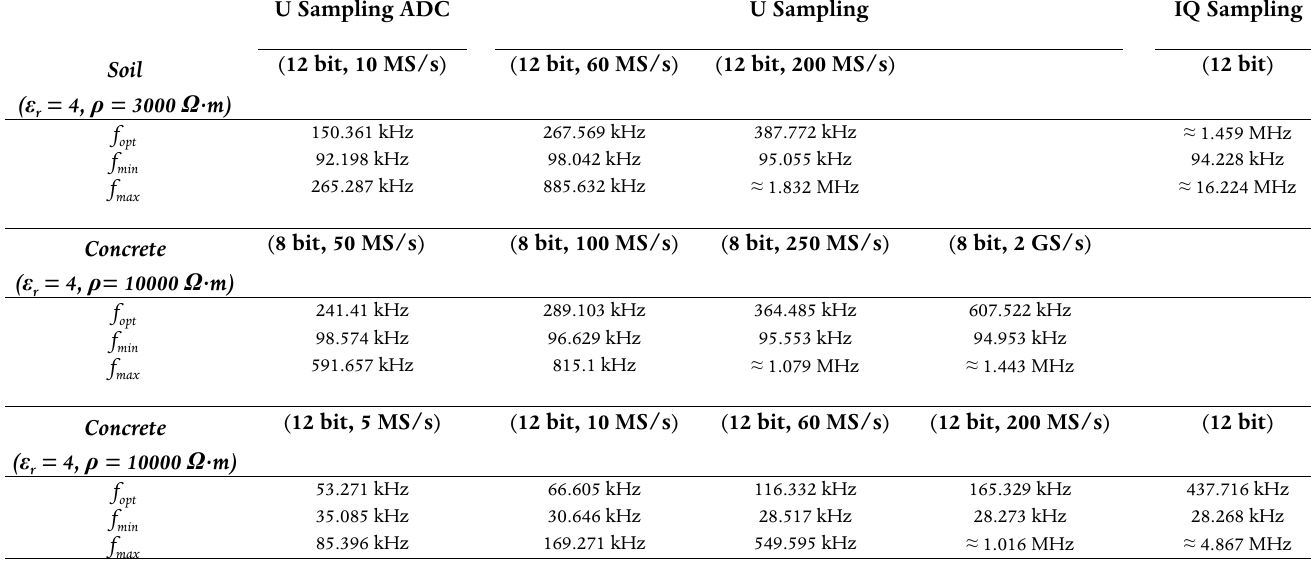
/ f ( f ), minimum and maximum frequencies, f r r